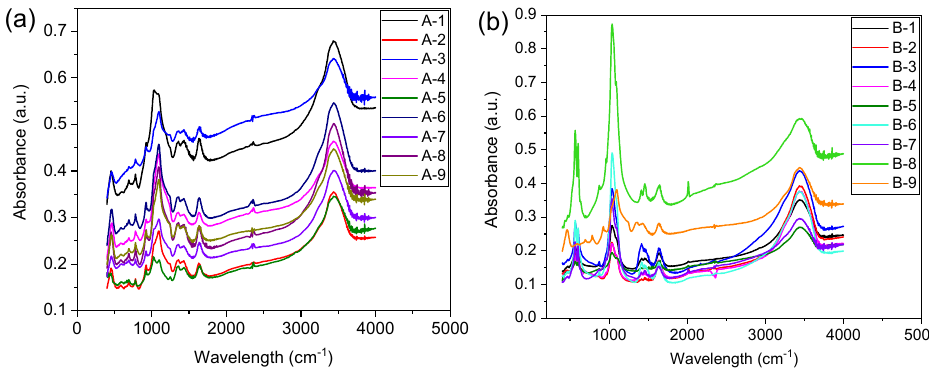
Figure 7. The FT-IR spectra of the samples ( a ) CABC and ( b ) PABC.